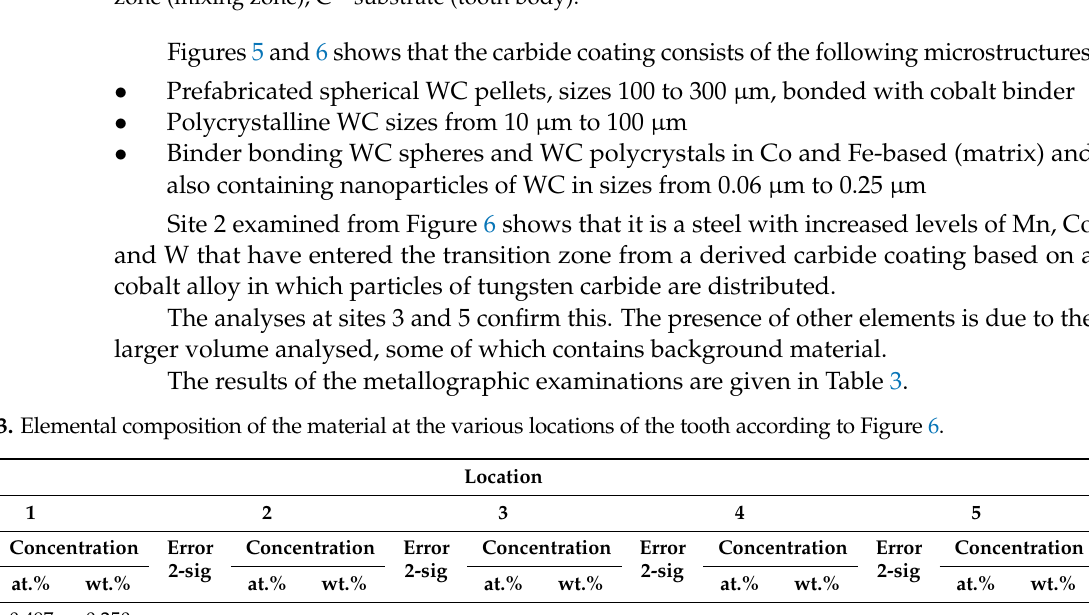
Table 3. Elemental composition of the material at the various locations of the tooth according to Figure 6.